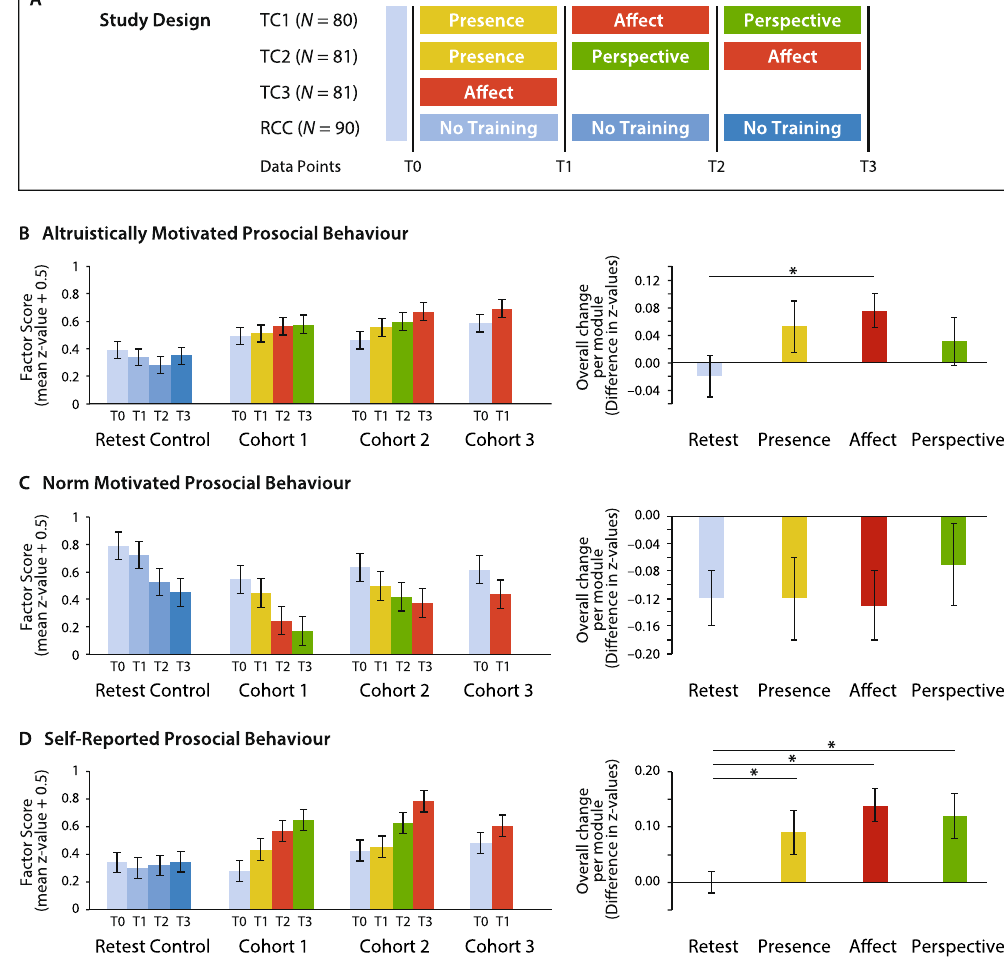
Figure 3. Results. Panel (A) Schematic depiction of the study design. Four cohorts were tested, three training cohorts (TC1, TC2, and TC3) and a retest control cohort (RCC). Colour coding in all panels is in accordance to this scheme, showing results for the RCC in blue, results after the Presence Module in yellow, results after the Affect Module in red, and results after the Perspective Module in green. Panel (B) Left graph: Results for scores on altruistically motivated prosocial behaviour for all cohorts and all time points. The y-axis displays factor scores as mean z-value + 0.5 (preventing negative scores and enhancing readability). Standard errors are displayed. The cohorts did not significantly differ in factor scores at T0. While no significant increases in factor scores were revealed for the RCC and Cohort 1 (TC1), TC2 and TC3 showed significant increases of altruistically motivated behaviour over time. Right graph: Average change scores of the factor altruistically motivated prosocial behaviour for the RCC and the three training modules of the ReSource Study. * depict significant differences from RCC (p < 0.05), corrected for multiple comparisons. Standard errors are displayed. Panel (C) Results for scores on norm motivated prosocial behaviour. Cohorts did not significantly differ in factor scores at T0. All cohorts showed a significant decrease in factor scores over time. Panel (D) Results for scores on the factor self-reported prosocial behaviour. Cohorts did not significantly differ in factor scores at T0. The RCC did not show significant change in factor scores over time, while all training cohorts